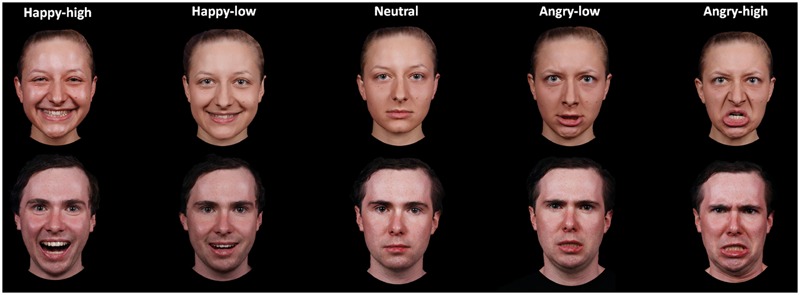
Examples of facial expressions for all experimental conditions.